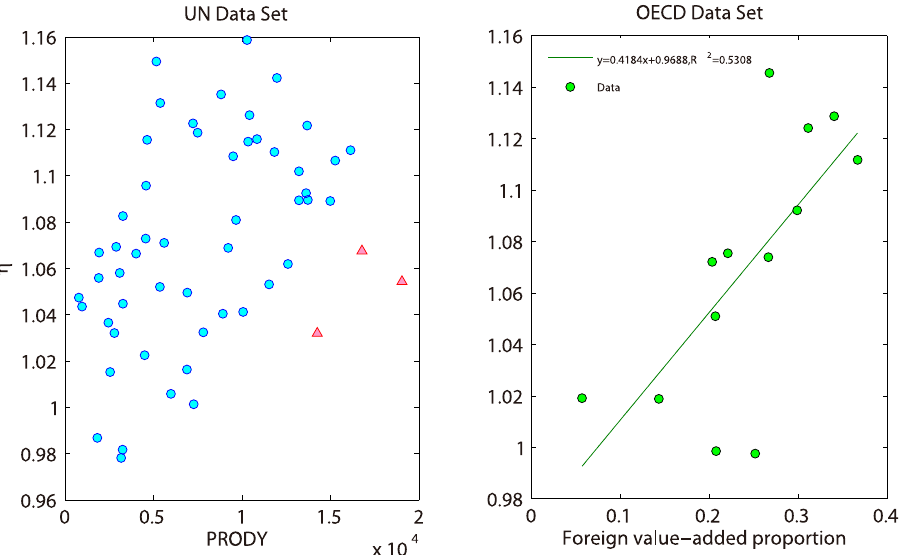
Figure 5. The relationship between g and PRODY of each 2-digit classification(left) in UN data set and g versus mean proportion of foreign value added for products in OECD data set.